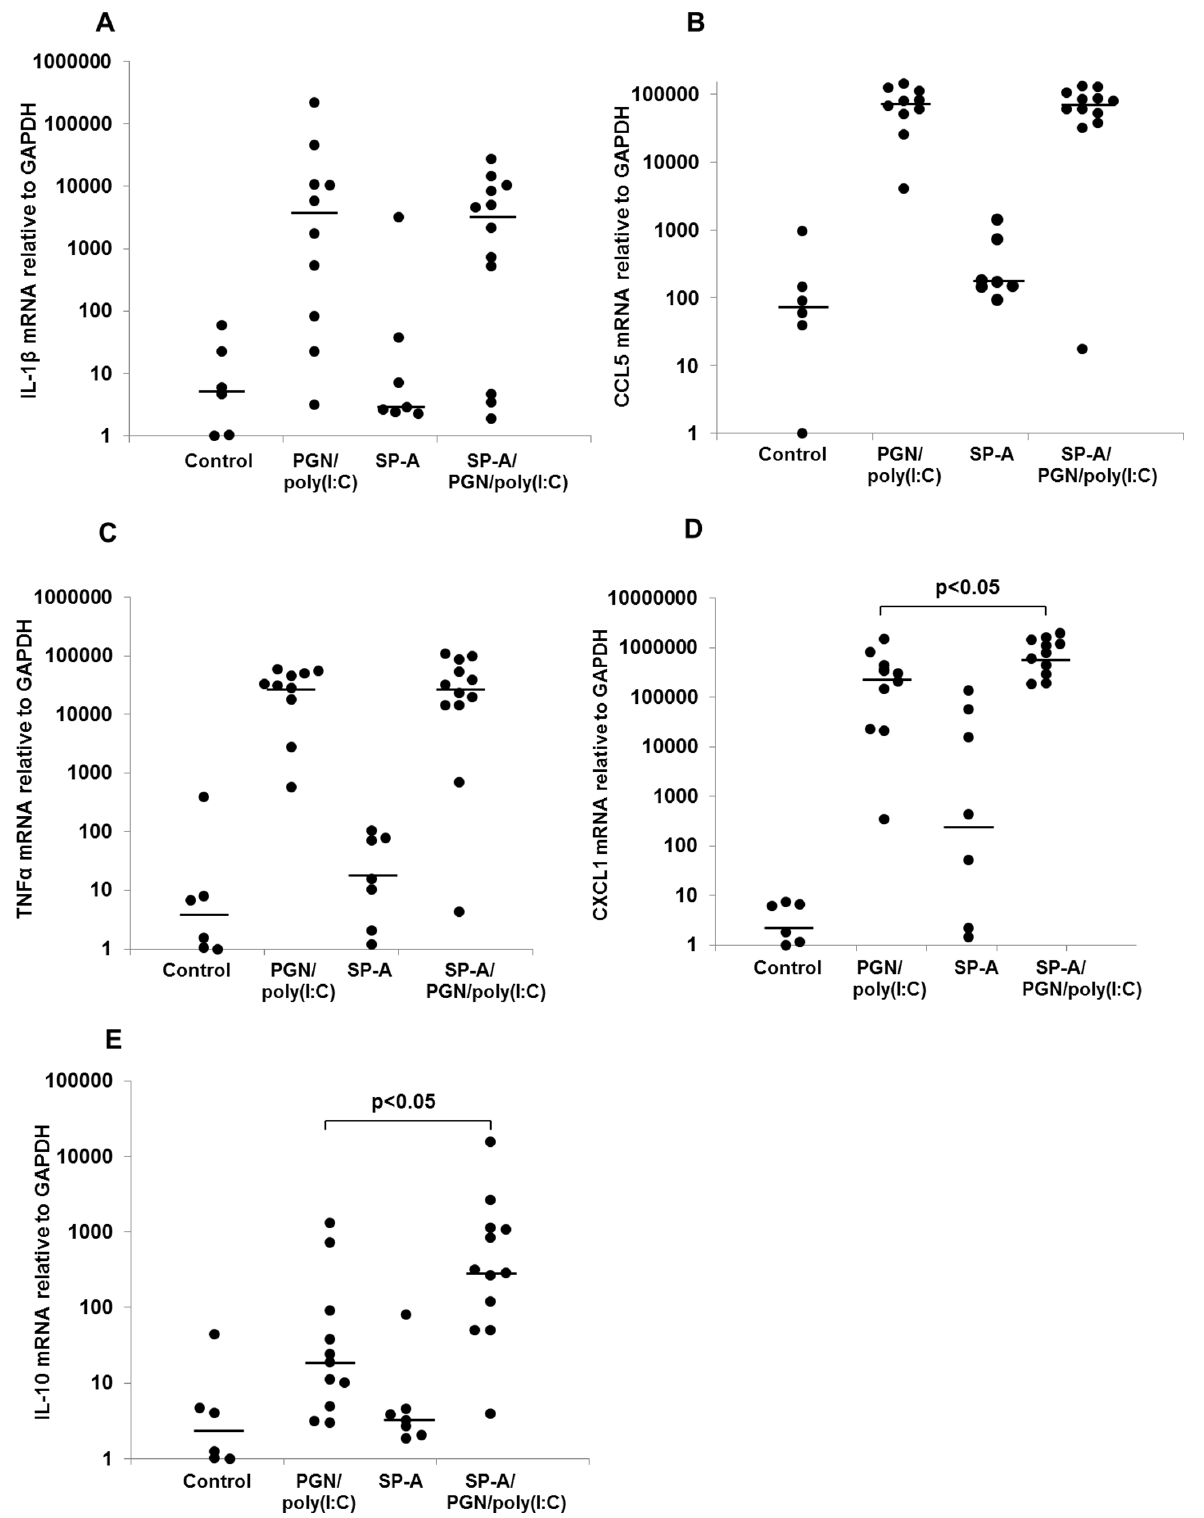
Figure 8. Effect of SP-A on the TLR ligand-induced expression of inflammation markers in uteri. RT-PCR analysis of mRNA for IL-1 b (A), CCL5 (B), TNF- a (C), CXCL1 (D) and IL-10 (E) normalized to GAPDH in uteri collected from CD-1 mice on day 14.5 of a 19- to 20-day gestation 8 hours after intrauterine administration of either PBS or PGN + poly(I:C) with or without SP-A. Data depicted are expression levels of cytokine for individual mice. N=6 for control, n=11 for PGN/poly(I:C), n=7 for SP-A and n=12 for SP-A/PGN/poly(I:C). P values were calculated by Mann-Whitney U test compare PGN + poly(I:C) with and without SP-A.